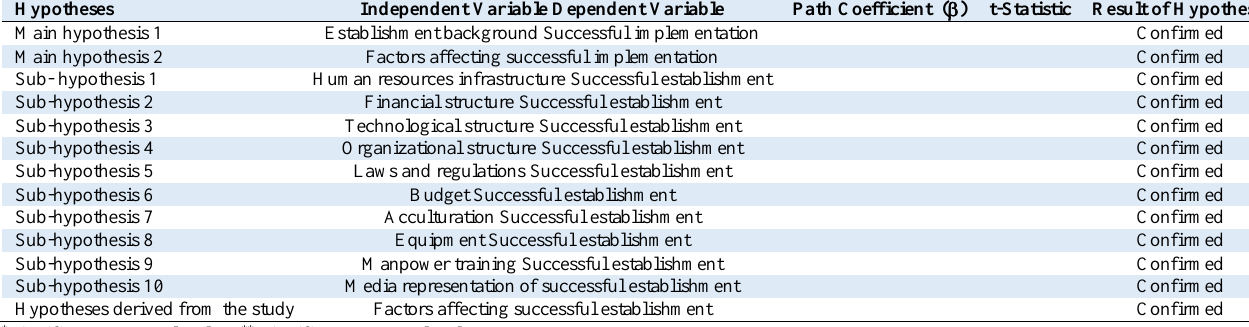
Table 5. Path coefficients and